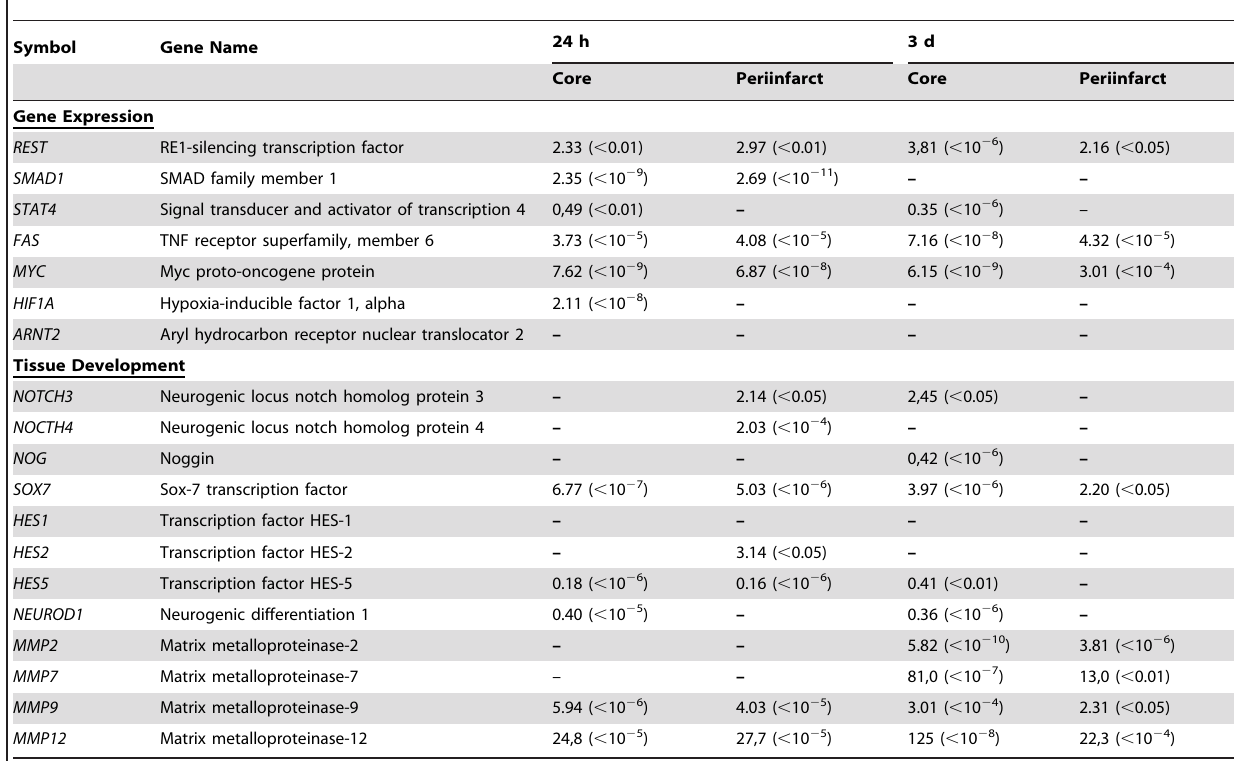
Table 3. Regulation of gene expression and tissue development-associated genes in the core and periinfarct after permanent focal cerebral